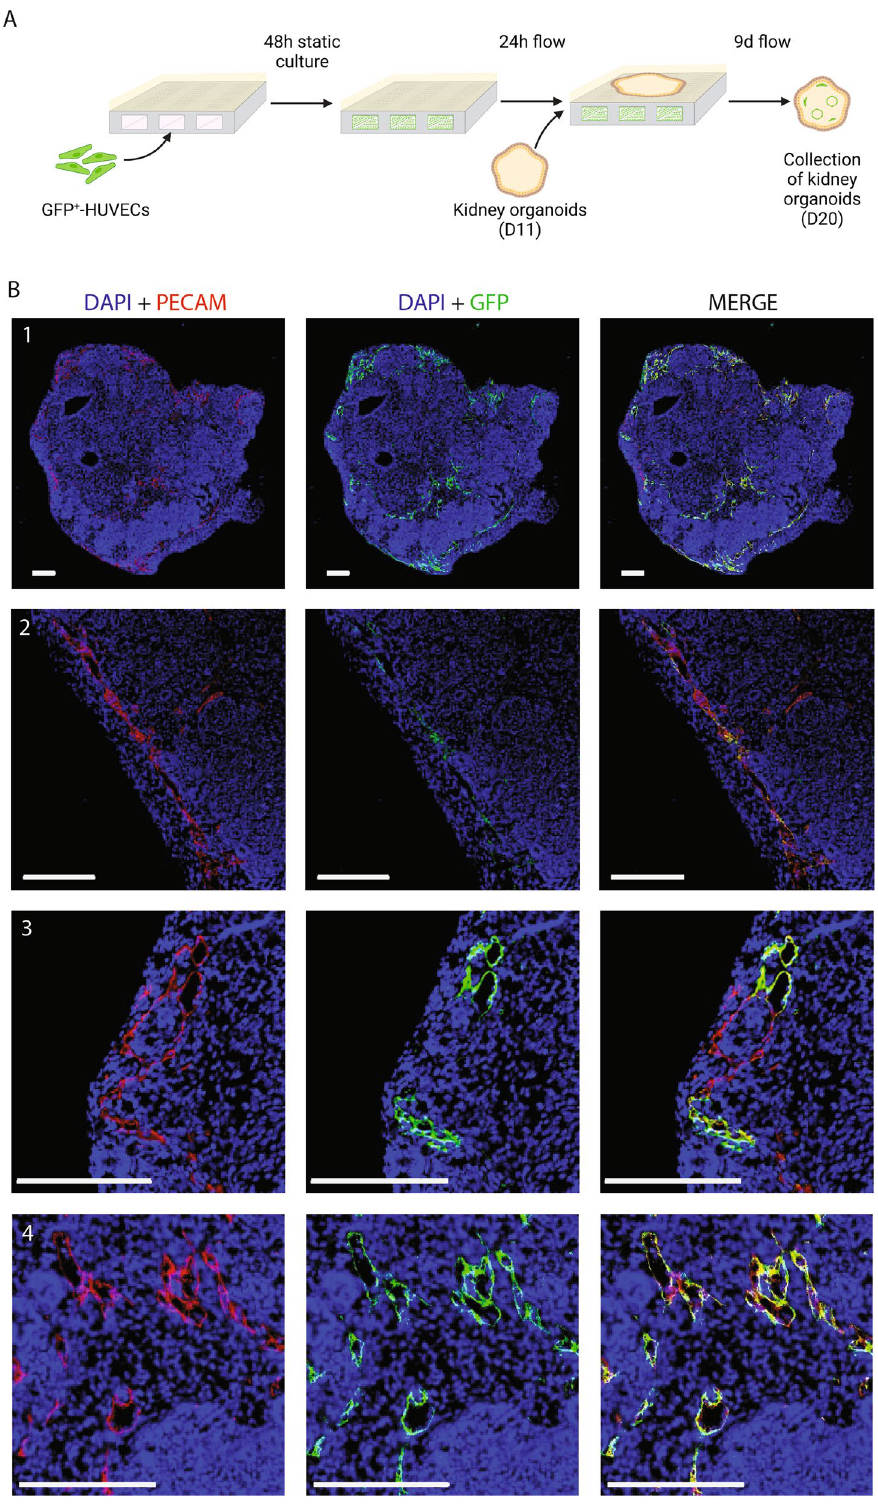
Figure 4. GFP + HUVECs migrate from the chip channels into the organoids and establish integrated vascular structures presenting an open lumen. ( A ) Schematic representation of the co-culture timeline of HUVECs and kidney organoids, indicating static culture, exercise of flow and addition and collection points of kidney organoids. ( B ) Immunofluorescent images of DAPI-PECAM-GFP of organoids co-cultured with GFP + HUVECs on the microfluidic chip system for 9 days. Shown in the images are vascular structures derived from the GFP + HUVECs integrated in the organoid tissue. ( B1 ) Whole organoid presenting vascular structures derived from GFP + HUVECs. ( B2 ) Detail image of large vascular structure on longitudinal section. Open lumen can be appreciated throughout the structure. ( B3 ) Detail image showing continuity of vascular structures formed by HUVECs (PECAM + , GFP + ) with native ECs (PECAM + , GFP - ). ( B4 ) Detail image of a transversal cut of several vascular structures with clearly visible open lumens. Scale bars = 200